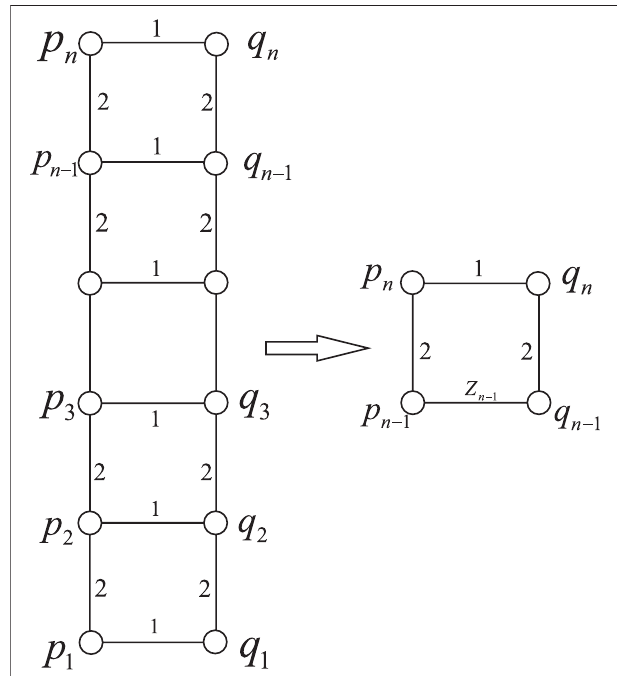
FIGURE 2 | Weighted ladder graph L * n (left) and the circuit reduction of L * n − 1 with respect to p n − 1 and q n − 1